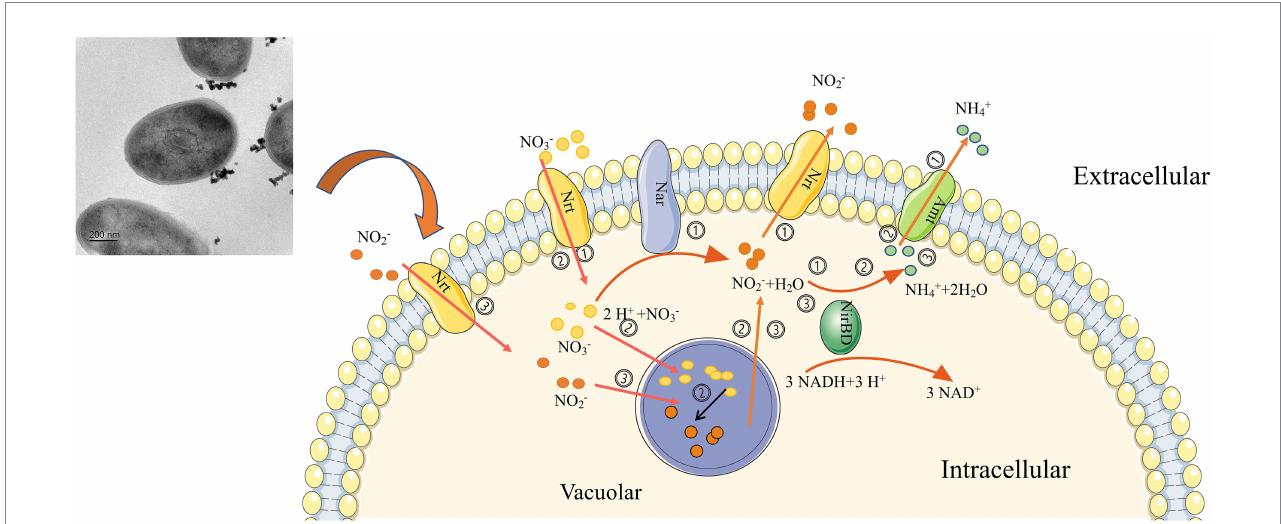
FIGURE 8 Graphical representation of nitrogen source utilization and accumulation by strain 24S4–2. (i) when nitrate or nitrite is the sole nitrogen source, nitrate is reduced to nitrite and ammonium by strain 24S4–2 and released to the extracellular, (ii) when nitrate is the sole nitrogen source, nitrate is accumulated in the vesicles by 24S4–2, and the accumulated nitrate is also reduced to nitrite, and when the external nitrogen source is absent, the accumulated nitrogen source is reduced to ammonium to maintain its life activities, and (iii) when nitrite is the sole nitrogen source, nitrite is accumulated in the vesicles like nitrate for later